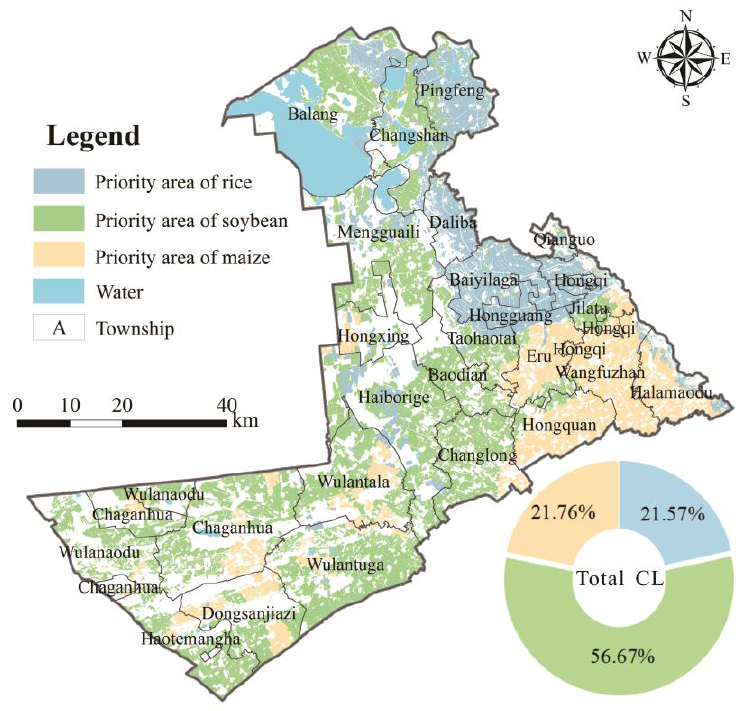
Figure 6. The distribution and proportion of cultivation priority types.